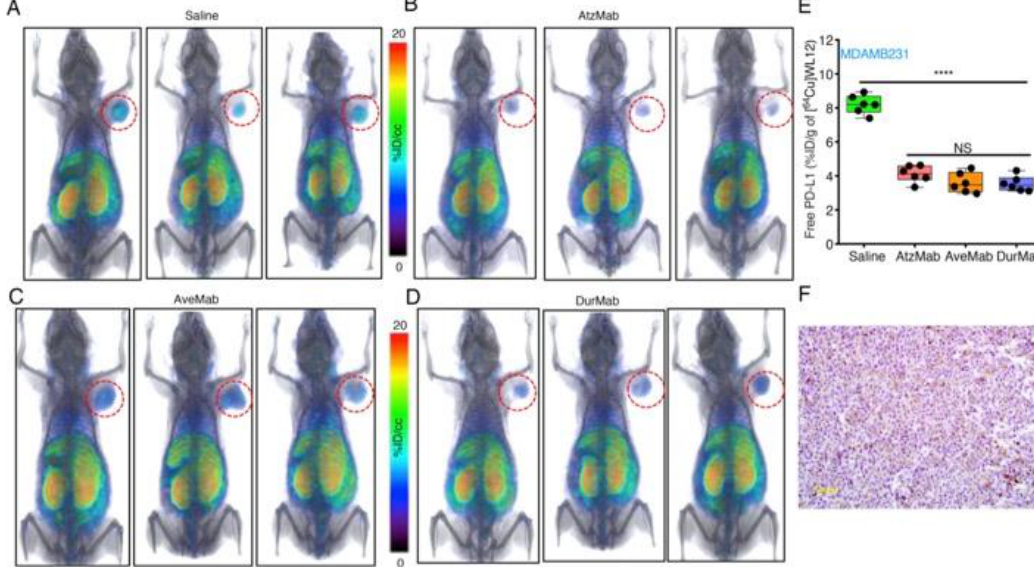
Figure 4. Tumor PD-L1 engagement by 3 distinct PD-L1 therapeutic antibodies quantified using [ 64 Cu] WL12. ( A – E ) [ 64 Cu]WL12 uptake in MDA-MB-231 xenografts is significantly reduced in mice receiving AtzMab (20 mg / kg), AveMab (10 mg / kg), or DurMab (10 mg / kg) 24 h prior to radiotracer injection. Whole-body volume-rendered [ 64 Cu]WL12 PET-CT images of saline- ( A ) AtzMab- ( B ) AveMab- ( C ) and DurMab-treated ( D ) mice, and ex vivo biodistribution ( E ) at 2 h after [ 64 Cu]WL12 injection ( n = 6–9 / group). ( F ) IHC staining for PD-L1 in the corresponding tumor. Scale bars: 100 µ m. Box-and-whisker graphs showing minimum to maximum and all data points, with the horizontal line representing the median. **** p < 0.0001; NS, not significant, by 1-way ANOVA and Dunnett’s multiple comparisons test in E (From